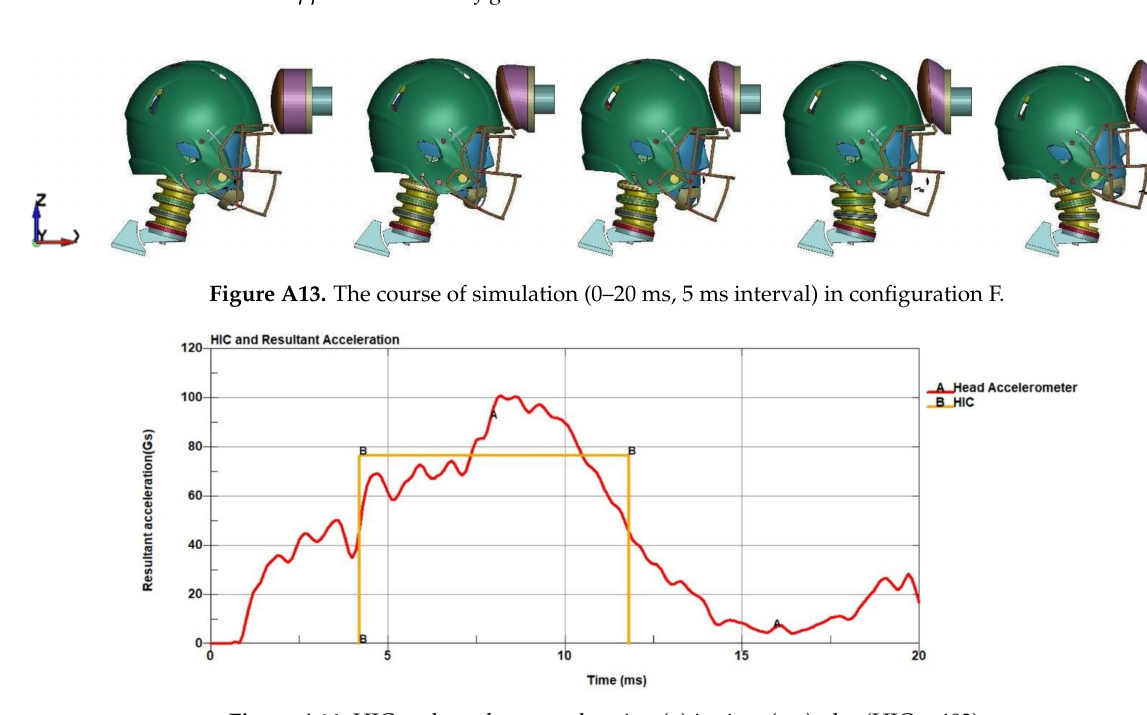
Figure A14. HIC and resultant acceleration (g) in time (ms) plot (HIC = 403). Brain Sci. 2021 , 11 , x FOR PEER REVIEW